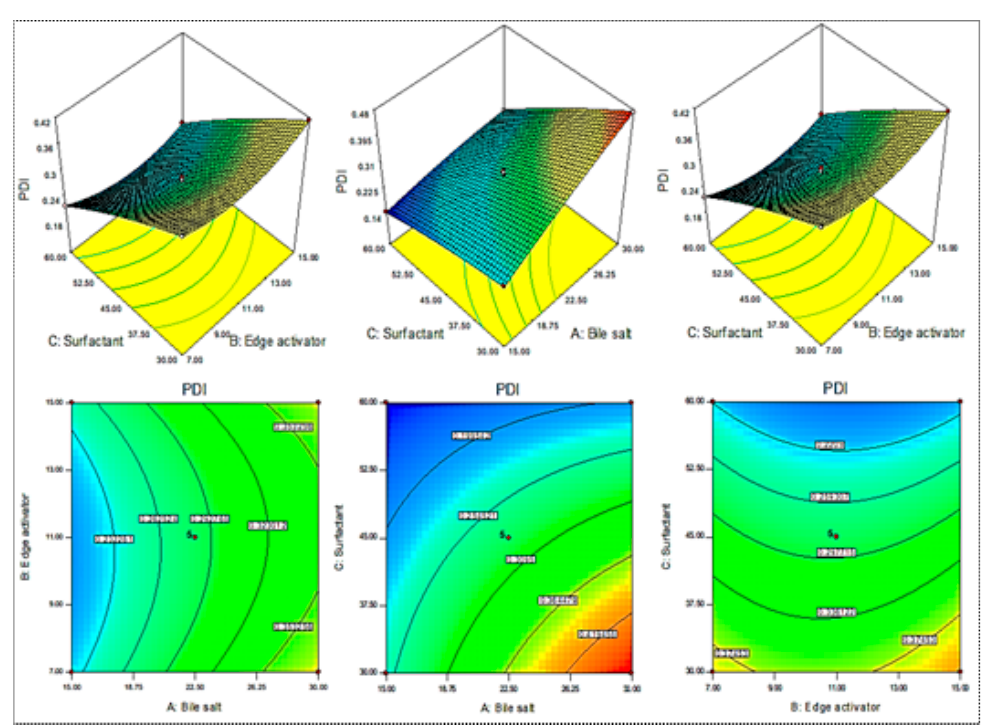
Figure 4. Effect of independent variables sodium deoxycholate (A), Cremophor EL (B), and Span 60 (C) on PDI (Y 3 ).